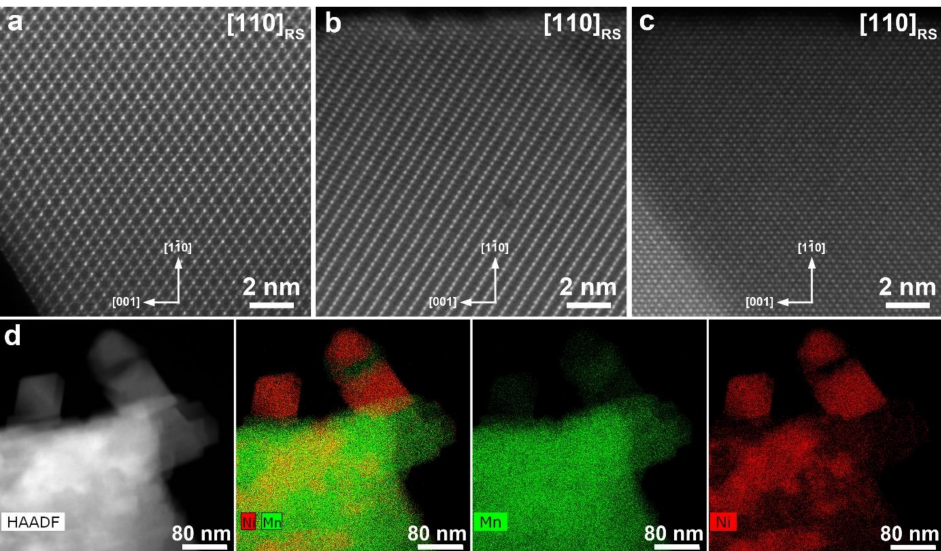
Figure 2. High angle annular darkfield scanning transmission electron microscopy (HAADF-STEM) images of the LiNi 0.5 Mn 1.5 O 4 ( a ), Li 1+ x M 1 − x O 2 ( b ) and Li z M 2 − z O 2 ( c ) phases in the Li 2 Ni 0.5 Mn 1.5 O 4 sample. The images are taken along the [110] direction of the parent rock-salt (RS) structure. HAADF- STEM image, the color-coded Mn and Ni compositional map and individual energy-dispersive X-ray (EDX) maps of Mn and Ni ( d ) demonstrating three phases with different Ni:Mn atomic ratio.